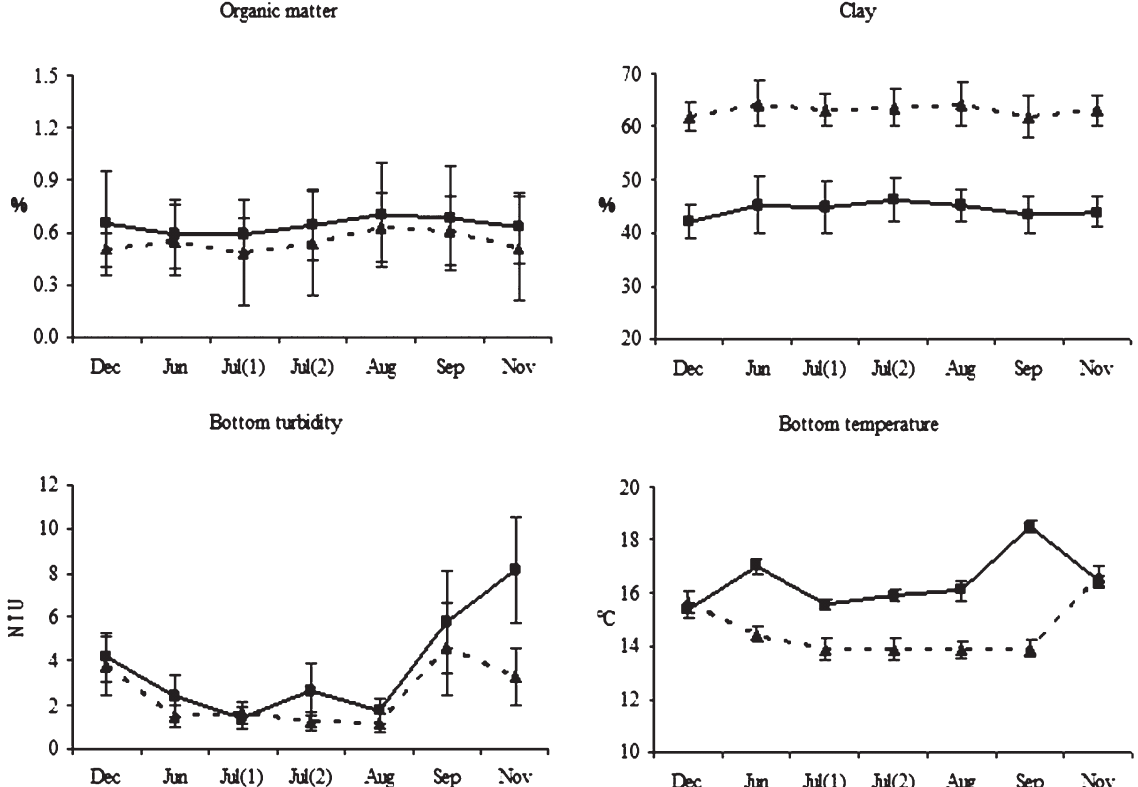
Fig . 2. – Temporal variability of the environmental variables: organic matter, % Clay and near-bottom turbidity and temperature (mean ± SD). Data were recorded at S1 (black line) and S2 (dotted line) from December 2002 to November 2003, including June samples, Jun; first cruise of July, Jul(1); second cruise of July, Jul(2); August, Aug; September, Sep; and November, Nov. This figure was published in Cartes et al .,